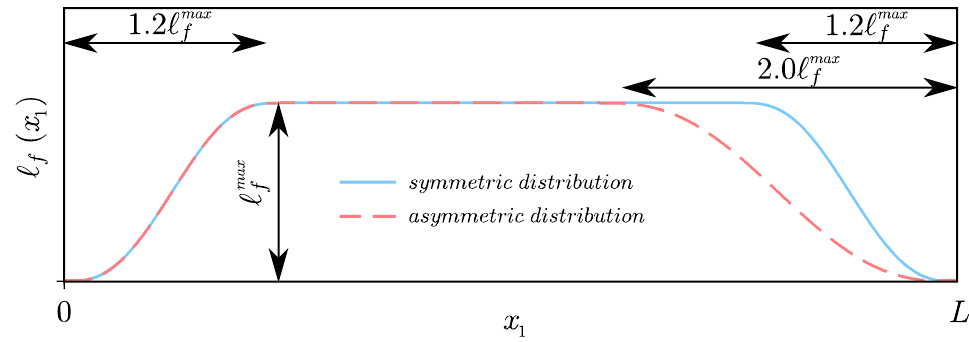
Figure 2. Smooth symmetric and asymmetric distribution of the length scale (cid:96) f along the beam